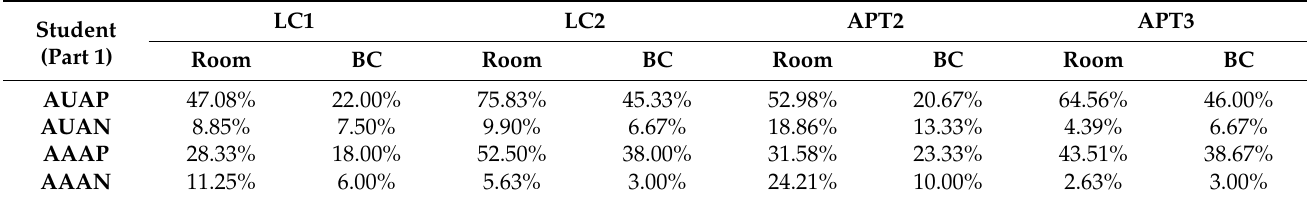
Table 10. Affordance presence for each design component in LC and APT projects reviewed by the student (Part 1).